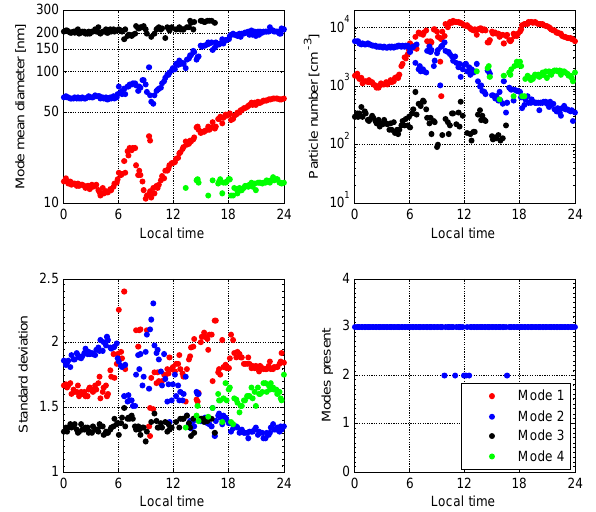
Fig. 7. Diurnal behaviour of the modal fitting parameters for Marikana.